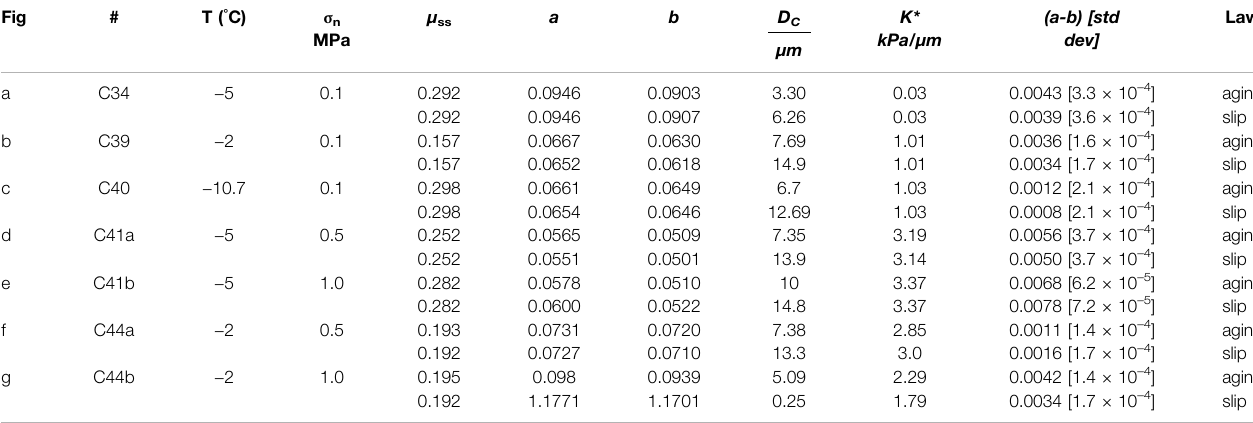
TABLE 2 | Fitted rate-state parameters to velocity up steps in Figure 7.